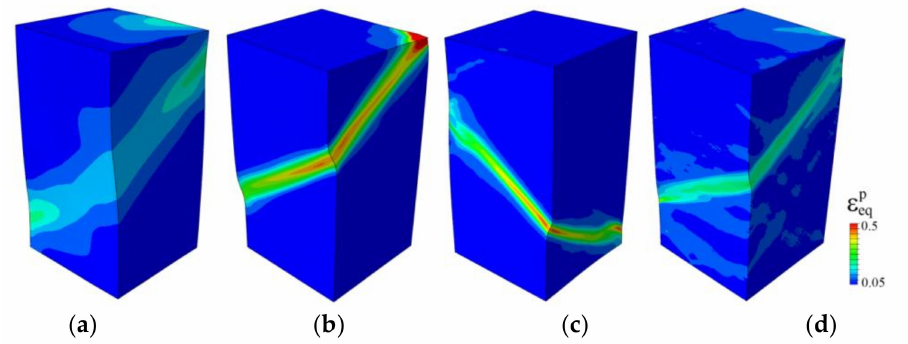
Figure 7. Equivalent plastic strain fields in the {100} single crystal models approximated by 30 × 60 × 30 ( a ), 60 × 120 × 60 ( b ), 100 × 200 × 100 ( c ), and 150 × 300 × 150 meshes ( d ) for the compression strain of